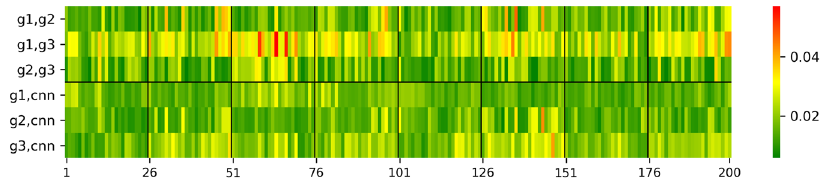
Fig. 5 Illustration of neural recording results. Heatmap of Hamming distances across all compartments for each individual B-scan (test set of 200 B-scans from 8 eyes). Hamming distances are shown between g1 and g2, g1 and g3, g2 and g3, g1 and CNN, g2 and CNN, and g3 and CNN. Green and red colors indicate small and large Hamming distances, respectively. Each eye contributed 25 B-scans. Thin vertical lines in black color separate eyes and the horizontal black line separates inter-human and machine versus human recordings, respectively. The ordering of B-scans within each eye was constant and no systemic difference was found regarding the location of the B-scan within the retina, i.e. whether it was a peripheral scan or a scan of the macula. There was very little variation across all individual B-scans (mostly greenish colors). Nevertheless, it is interesting that between the graders a few B-scans are shown in red, whereas compared to CNN no images were marked in red.